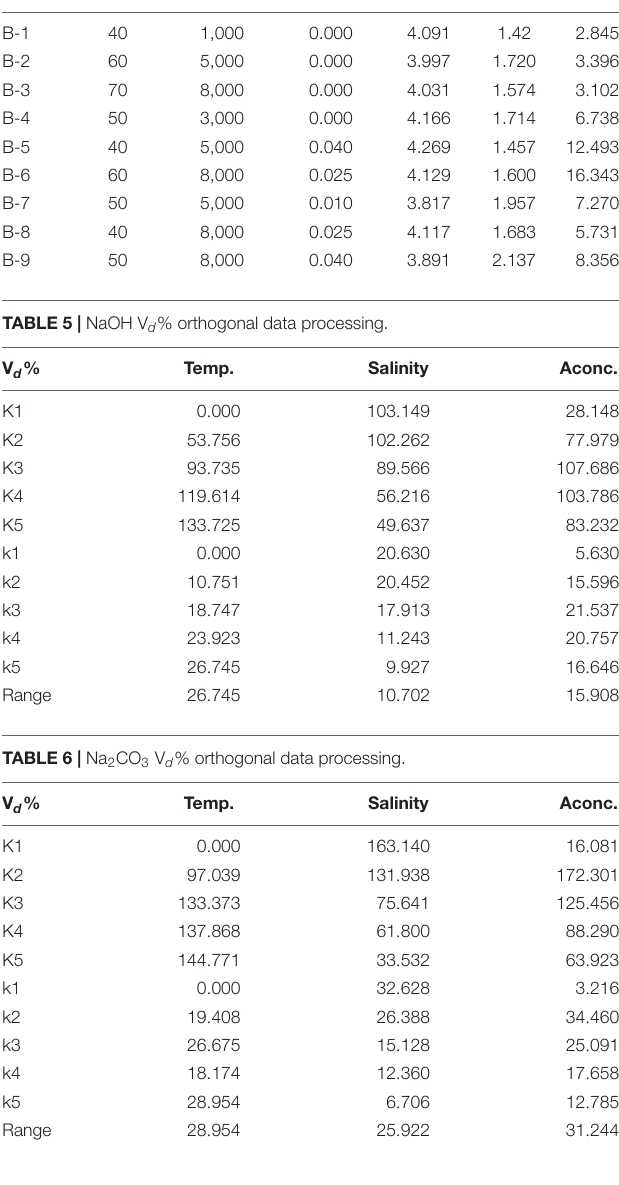
table to conduct the bottle test (Fan and Chen,